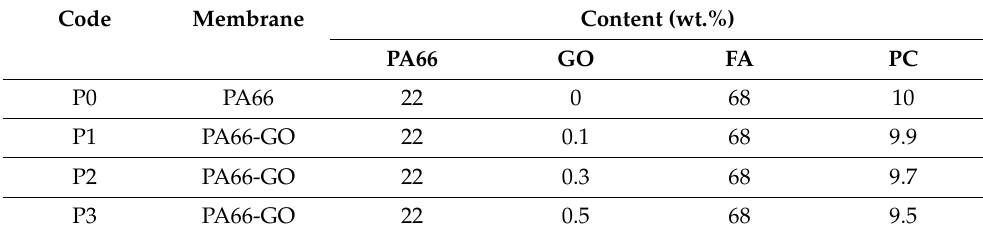
Table 1. Casting solution composition and coding of different